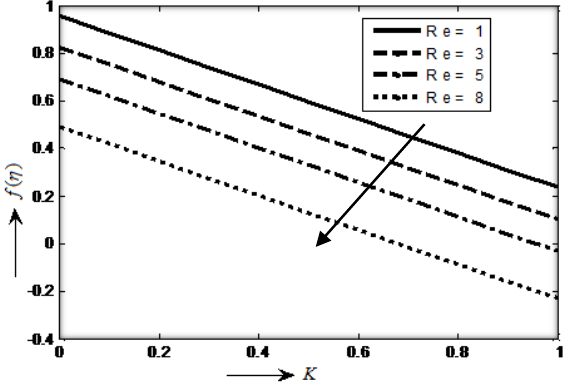
Figure 11. Variation of fluid velocity f (  ) against K for Reynolds number Re (1, 3, 5, 8) by taking  = 1.6, M = 0 and  = 0.5